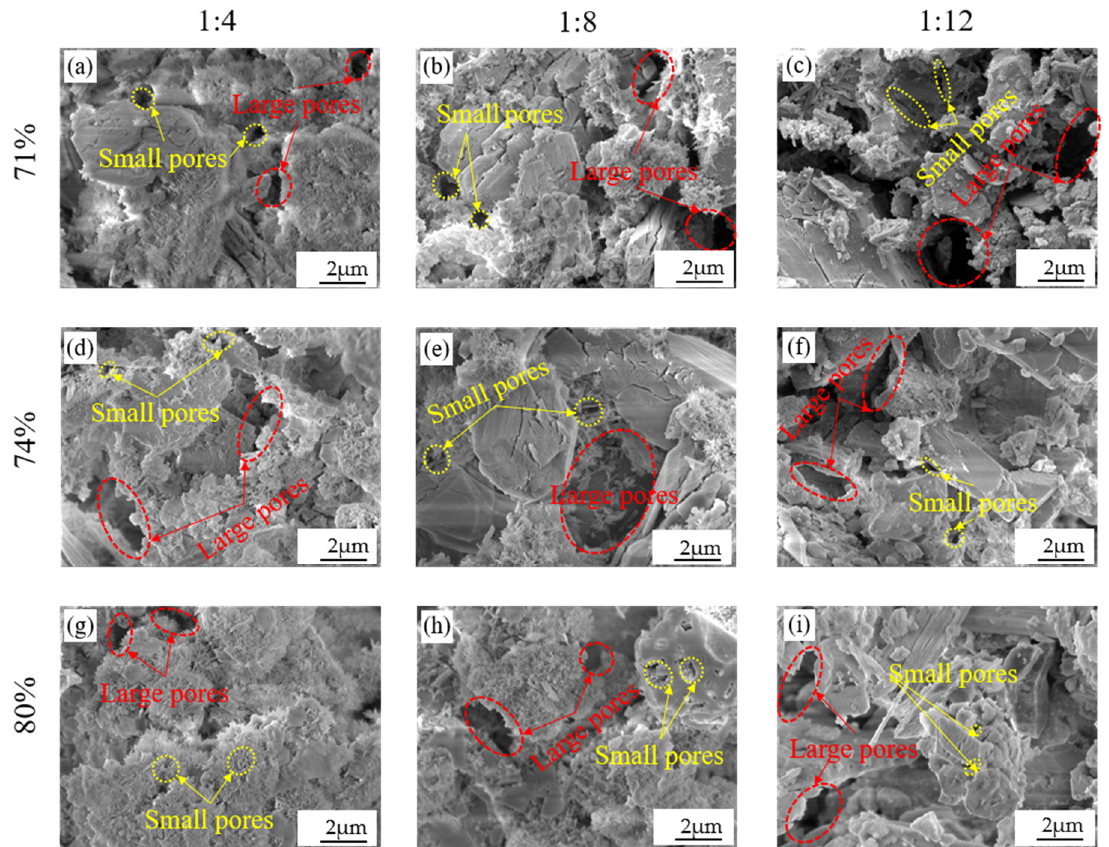
Figure 13. Microstructure images of backfill with a concentration of 71%, 74%, and 80%. ( a )–( i ) represent SEM images of backfills with different cement–tailings ratio and solid mass concentration.